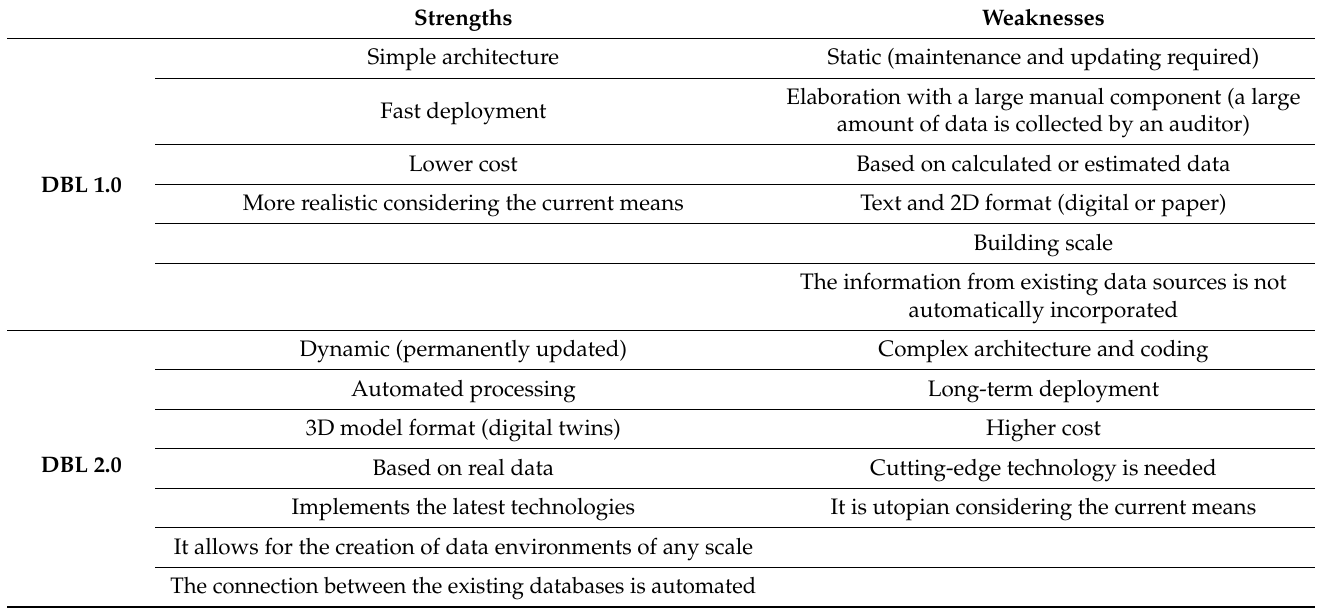
Table 1. Comparison of the two generations of DBL. Source: adaptation from ‘European Digital Building Logbook: definition of its functionalities to maximise its potential’ [5]. Abbreviations: Digital Building Logbook